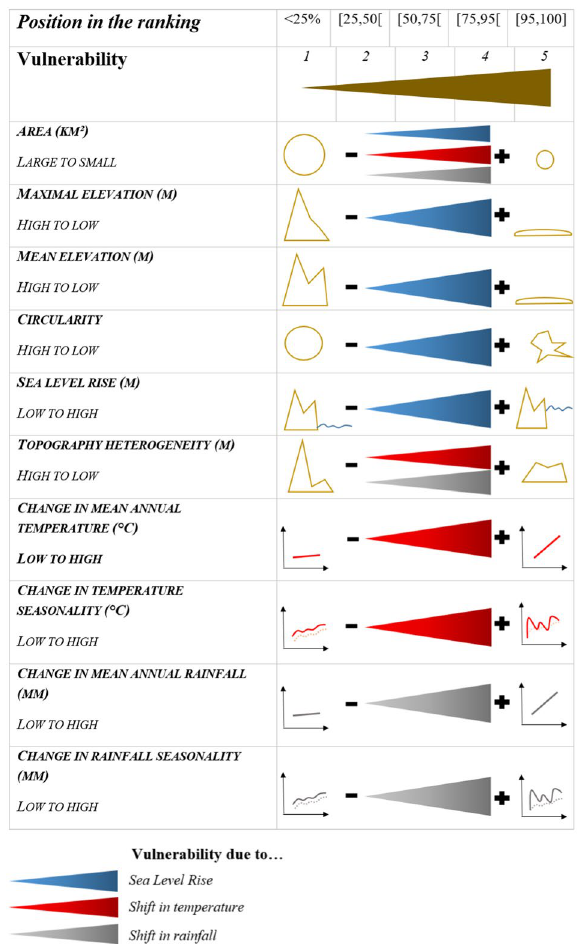
Figure 7. Vulnerability scores for each factor of vulnerability and their associated threat. For each factor, islands were ranked according to the expected influence of that factor on their vulnerability. Islands were then assigned to five classes (from low (1) to high (5)) depending on their ranking position. For example, the highest score was attributed to islands in the top